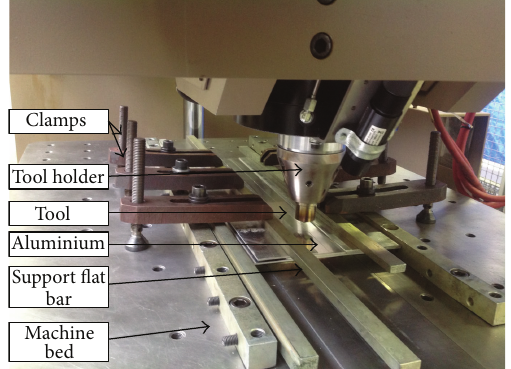
Figure 5: Experimental setup.